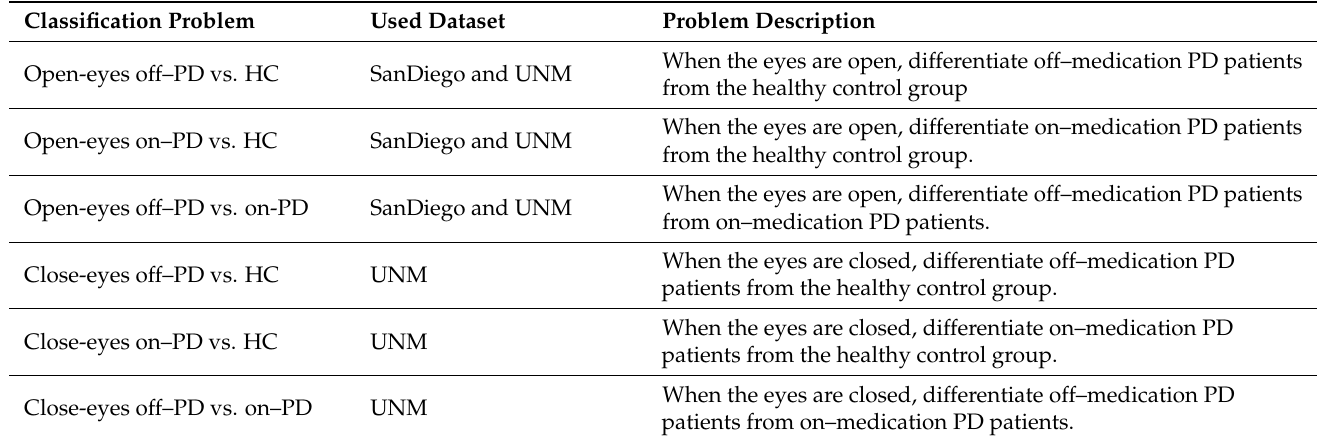
Table 3. Summary of the addressed classification problem formulations in the present